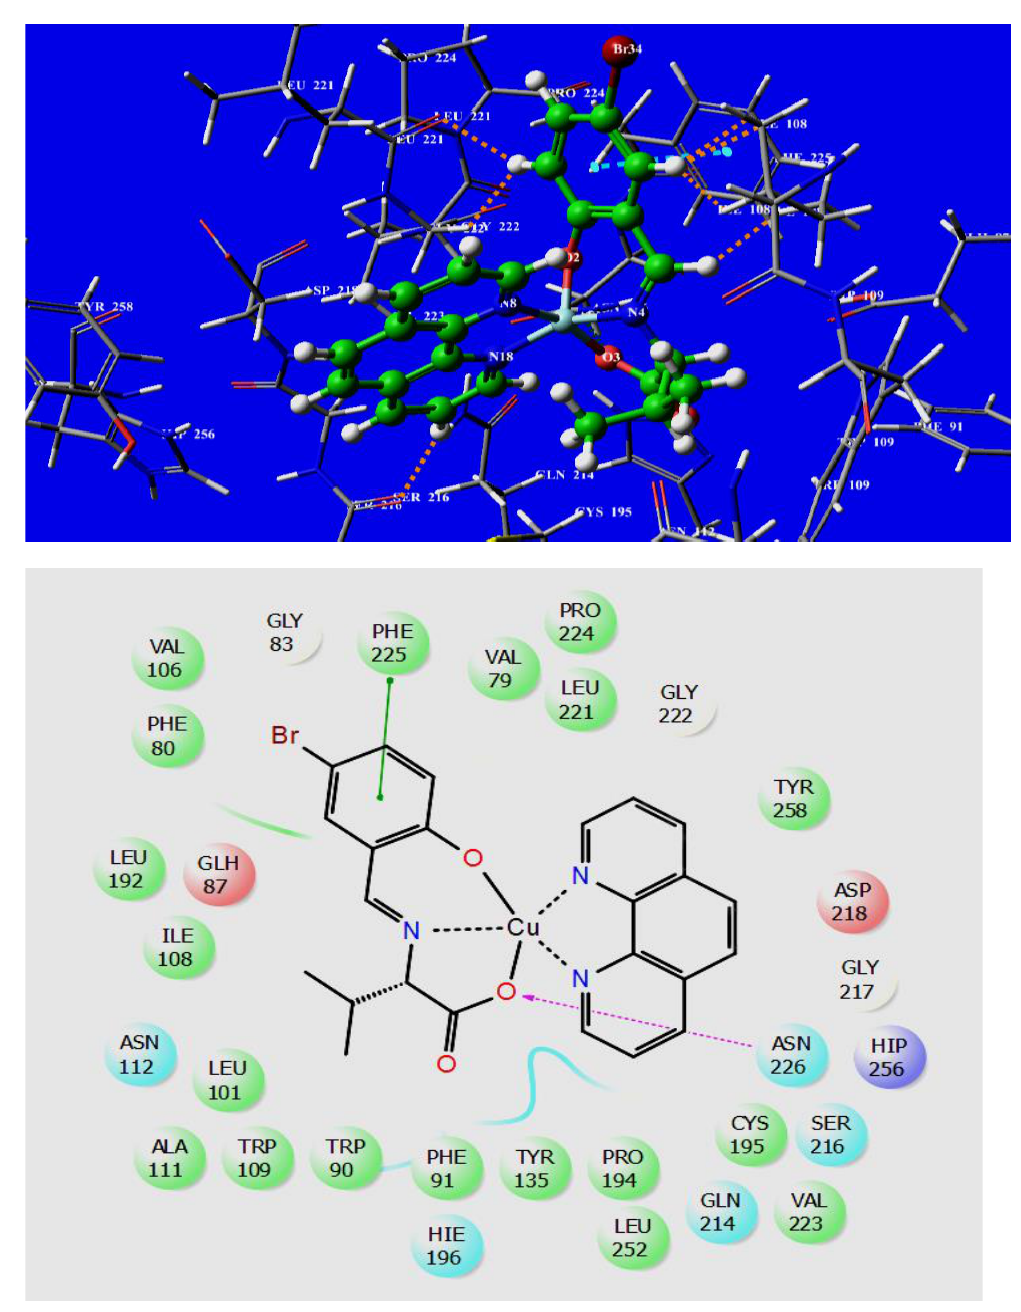
Figure 8. The 3D and 2D interactions of [Cu(L)(phen)] complex 1c located in hydrophobic sites of thymidylate synthase receptor.